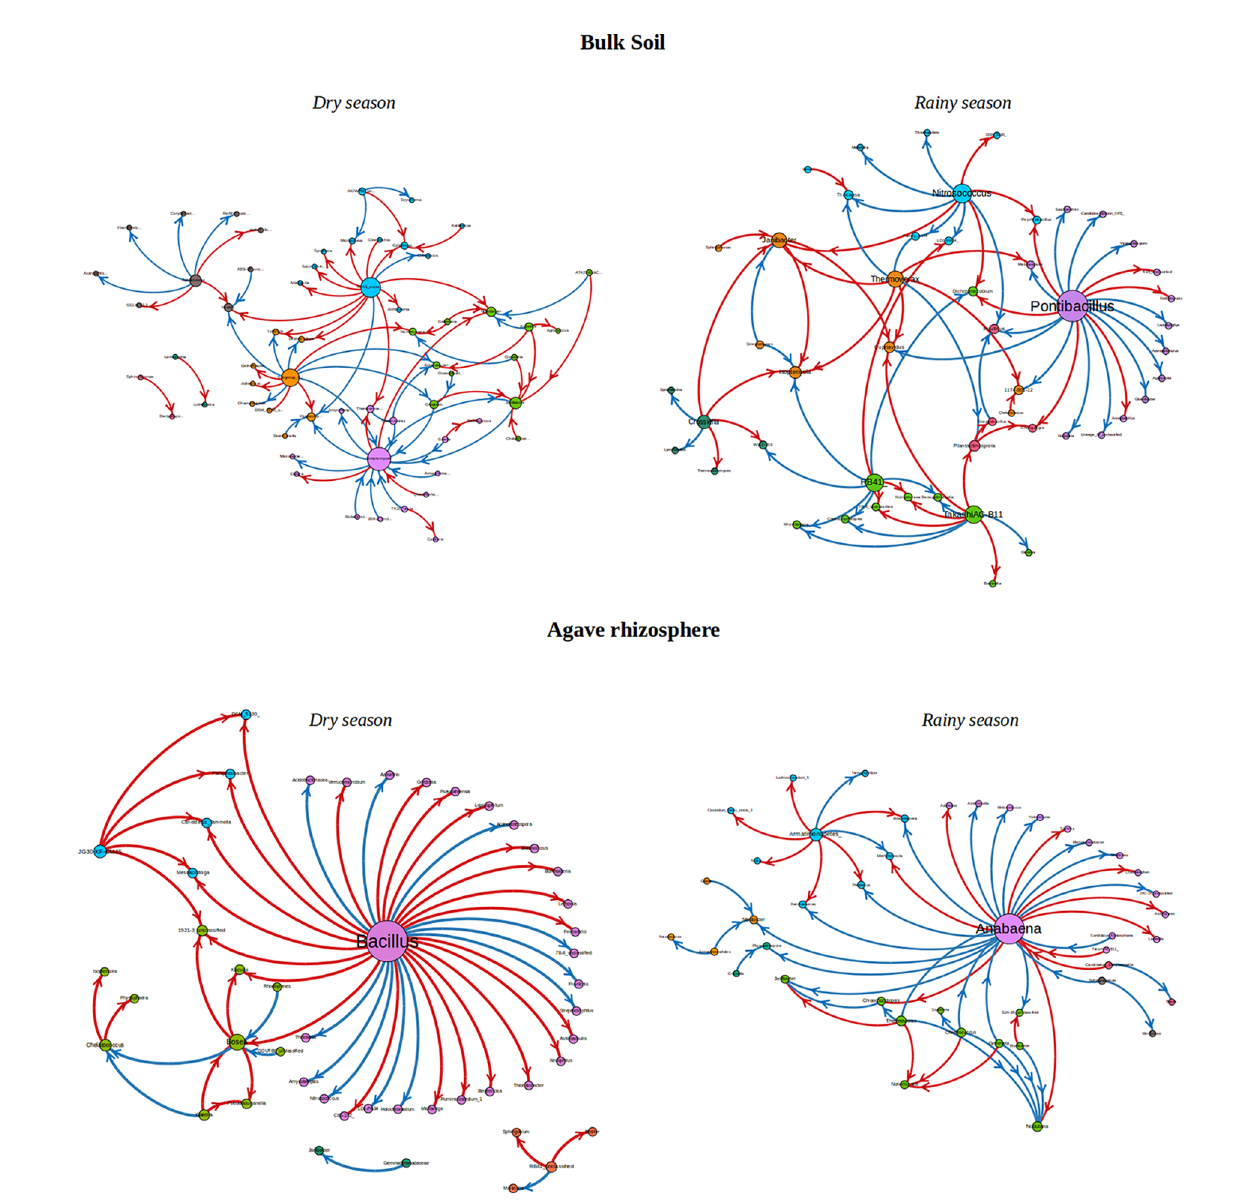
FIGURE 4 | Interaction networks found for Rhizosphere and bulk soil over two seasons. The size of the nodes represents the importance in the network, i.e. the bigger the node is the more connections it has with other OTUs. Red rows are negative interactions, while blue rows are positive interactions. The color of each node represents the community to which it